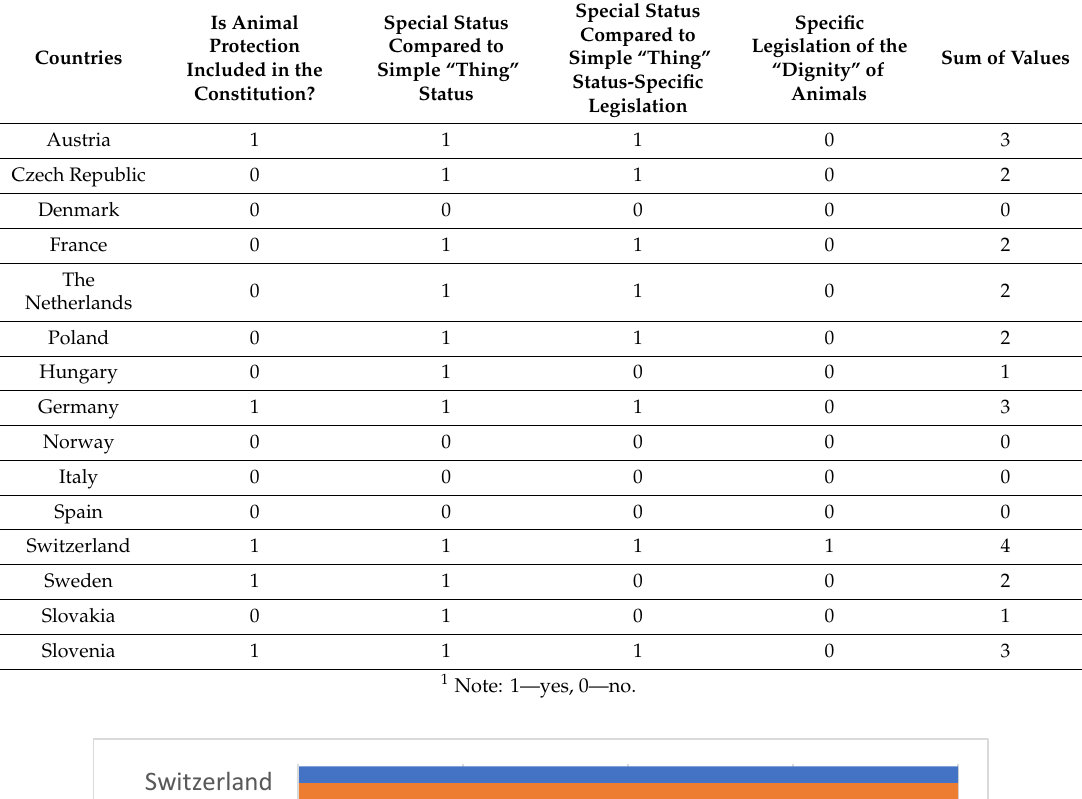
Table 2. Evaluation of 15 European countries according to the legal status of animals. 1.